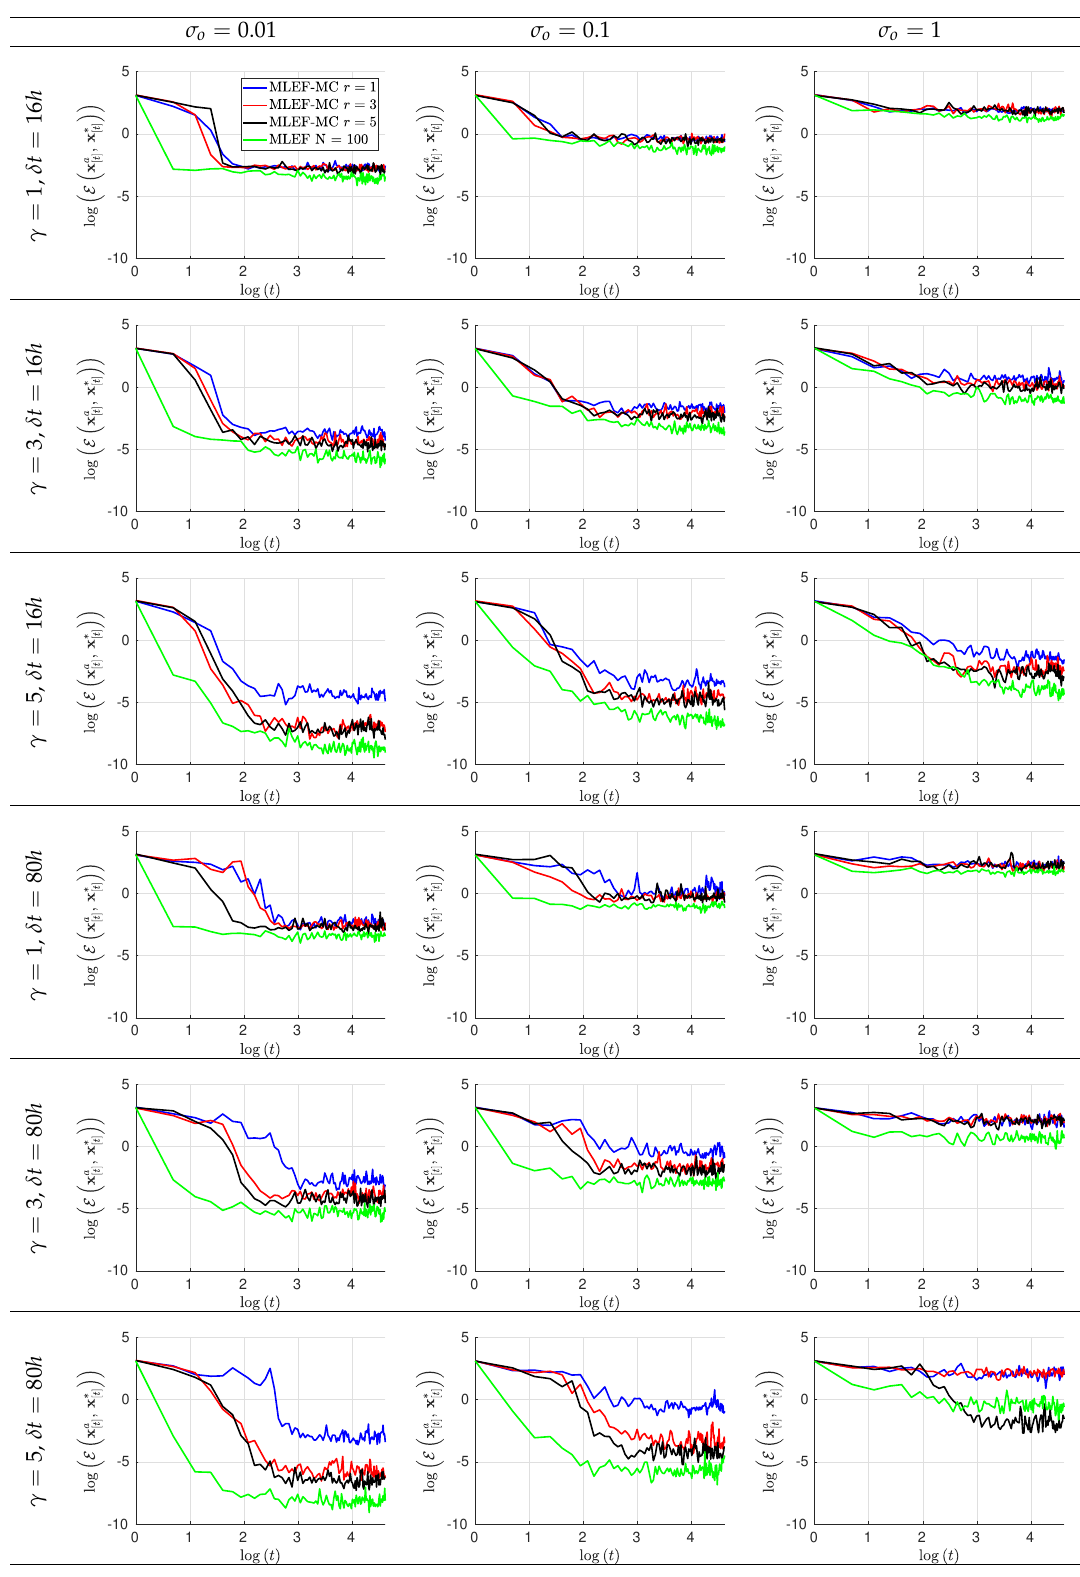
Figure 4. Error evolution in the log-scale of the compared filter implementations. Different time frequencies of observations were employed during the experiments. The percentage of observations from the model state reads s =